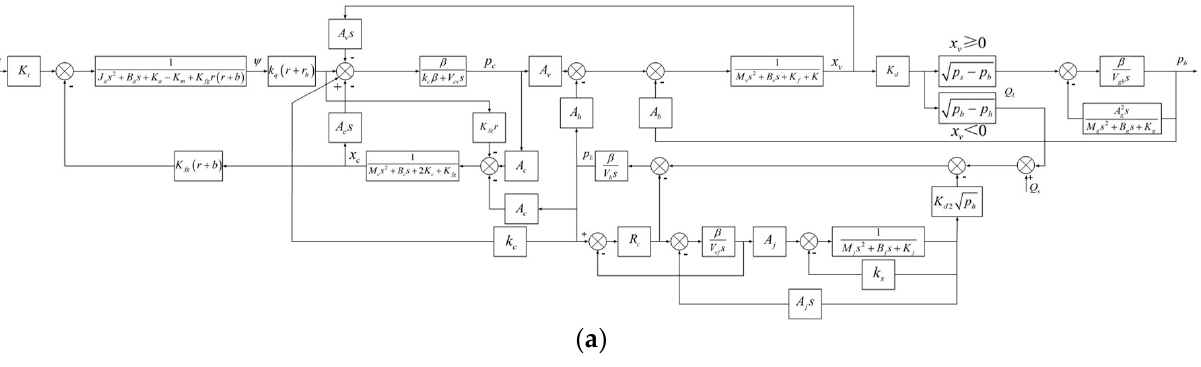
( b ) The following is the logical diagram of our hydraulic system ： ( c ) Figure 4. ( a ) Block diagram of ABPSVCS. ( b ) Flow block diagram of ABPSVCS. ( c ) Logical block diagram of hydraulic system.